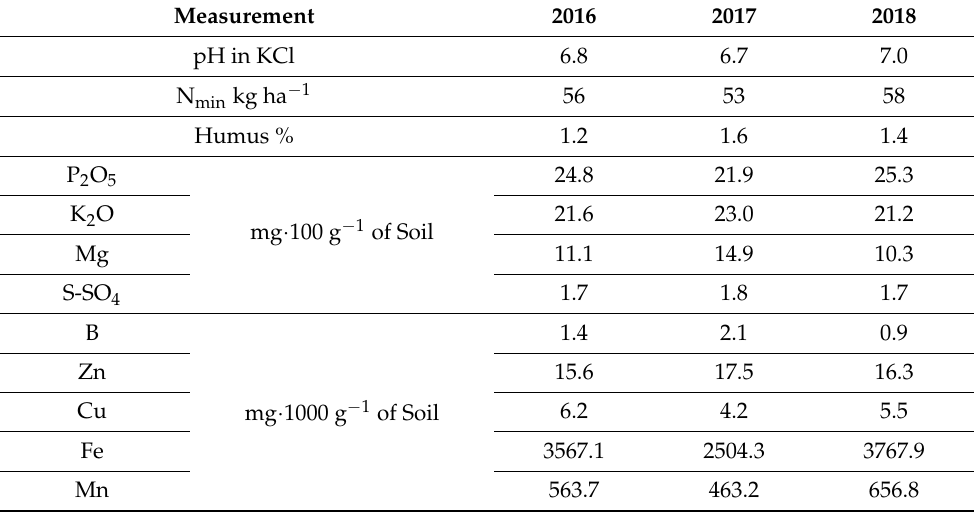
Table 2. Chemical properties of soil at the depth of 0–60